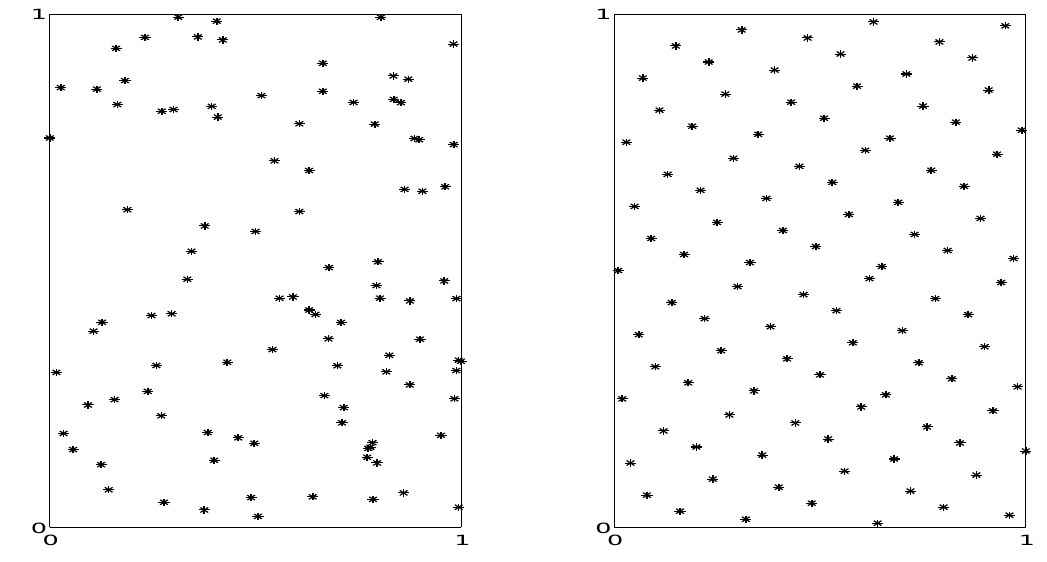
Figure 1. (Pseudo)—random and quasi-random point sets on the unit